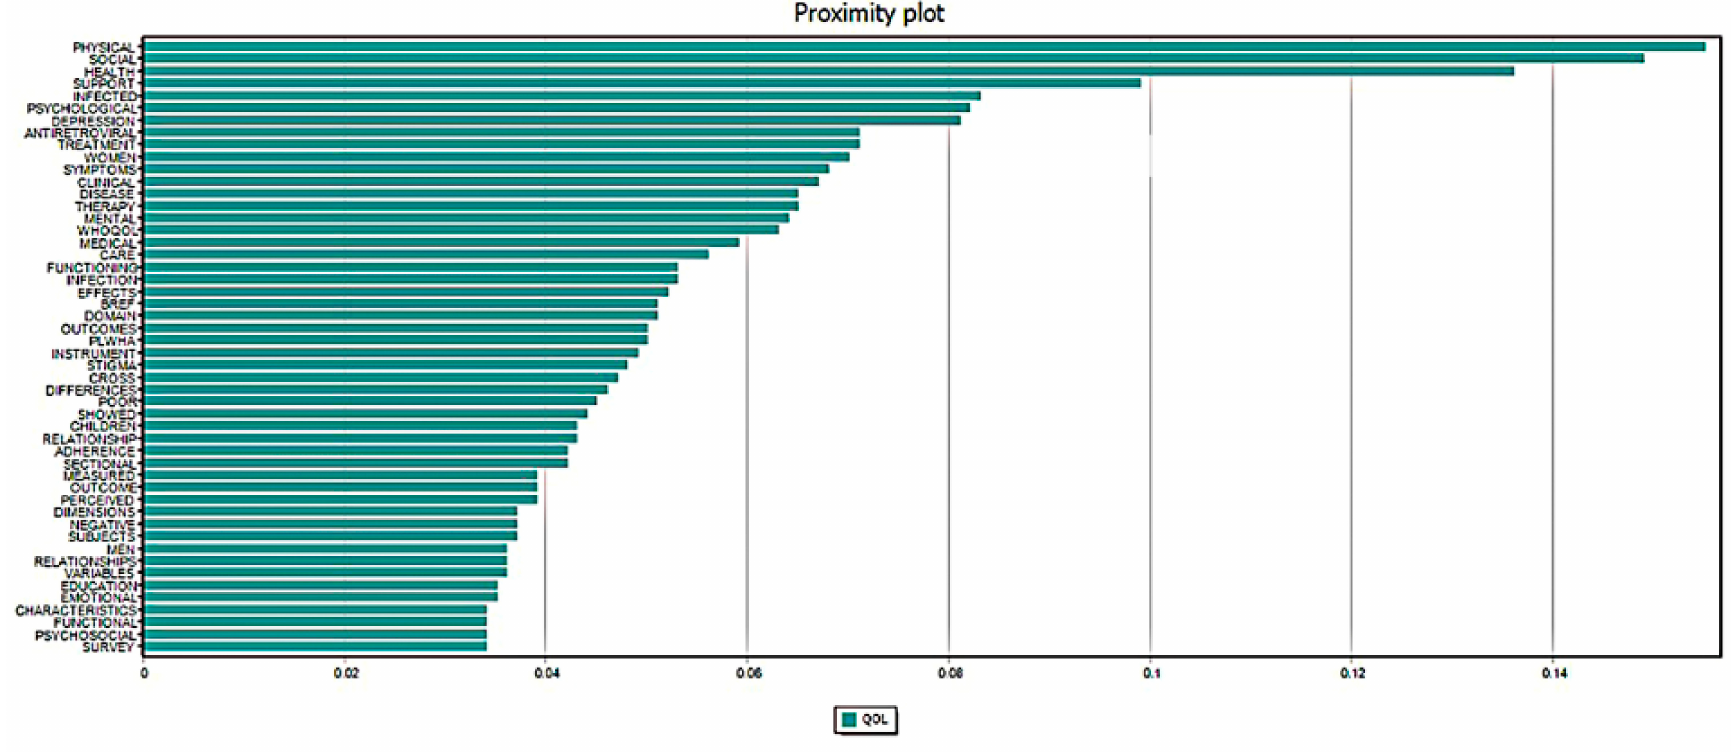
Figure 3. Proximity Plots of “quality of life” with the top 50 most frequent concurrence terms in